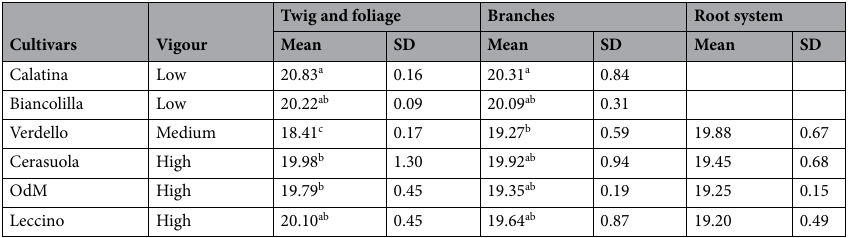
Table 1. Mean calorific values (MJ/kg) of dry matter measured in the different organs’ in the cultivars studied. Means within columns with the same small letters are not significantly at P < 0.05 (n = 3), SD is standard deviation. For the root system there are not small letters because few